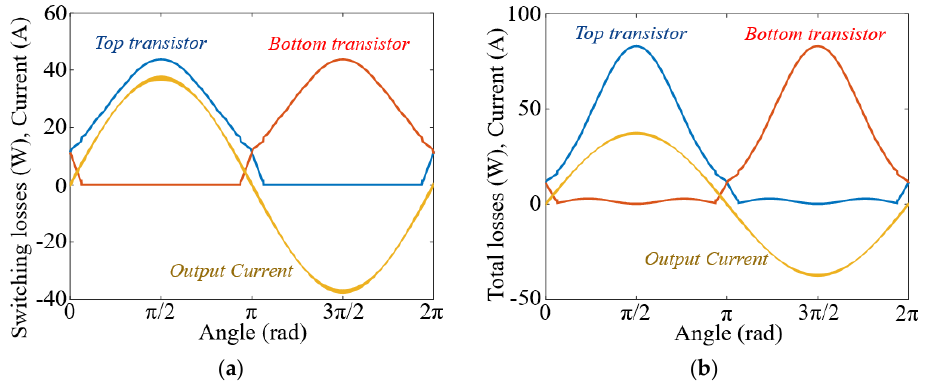
Figure 7: Instantaneous values of ( a ) switching losses averaged in a switching period and ( b ) total (conduction + switching) losses in the top and bottom switches of one bridge leg of a three-phase inverter having V DC = 540 V, I out = 26.3 A, φ = 0°, M i = 1, F sw = 50 kHz. The modulation method used was sinusoidal (SPWM).